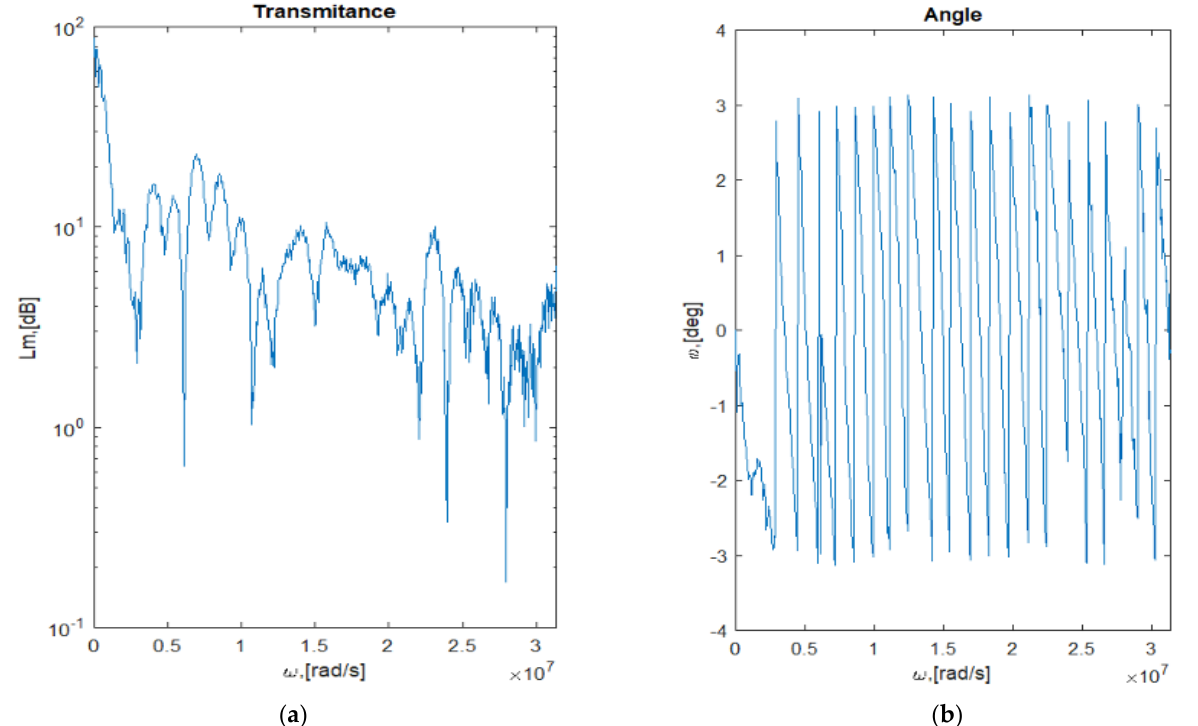
Figure 11. ( a ) Transmittance between pins A and B of the first motor and the other motor; ( b ) Angle of transmittance between pins A and B of the first motor and the other motor.